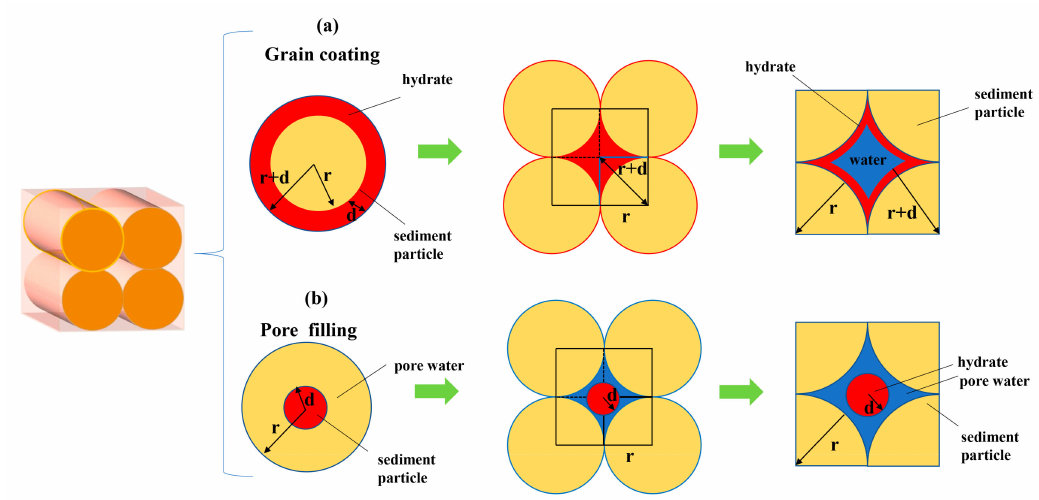
Figure 6. Two filling modes of cubic